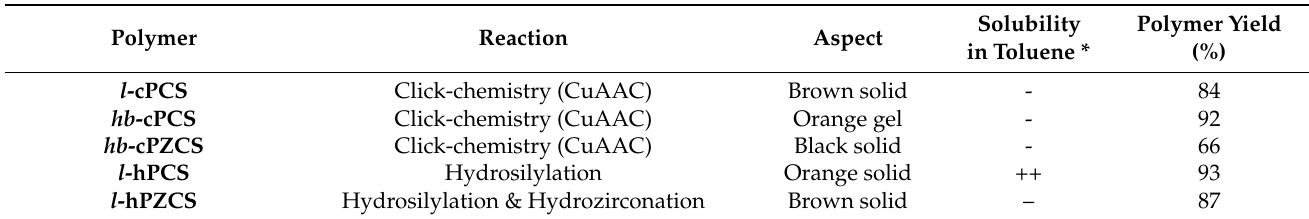
Table 1. Characteristics of the different synthesised polymers and their respective